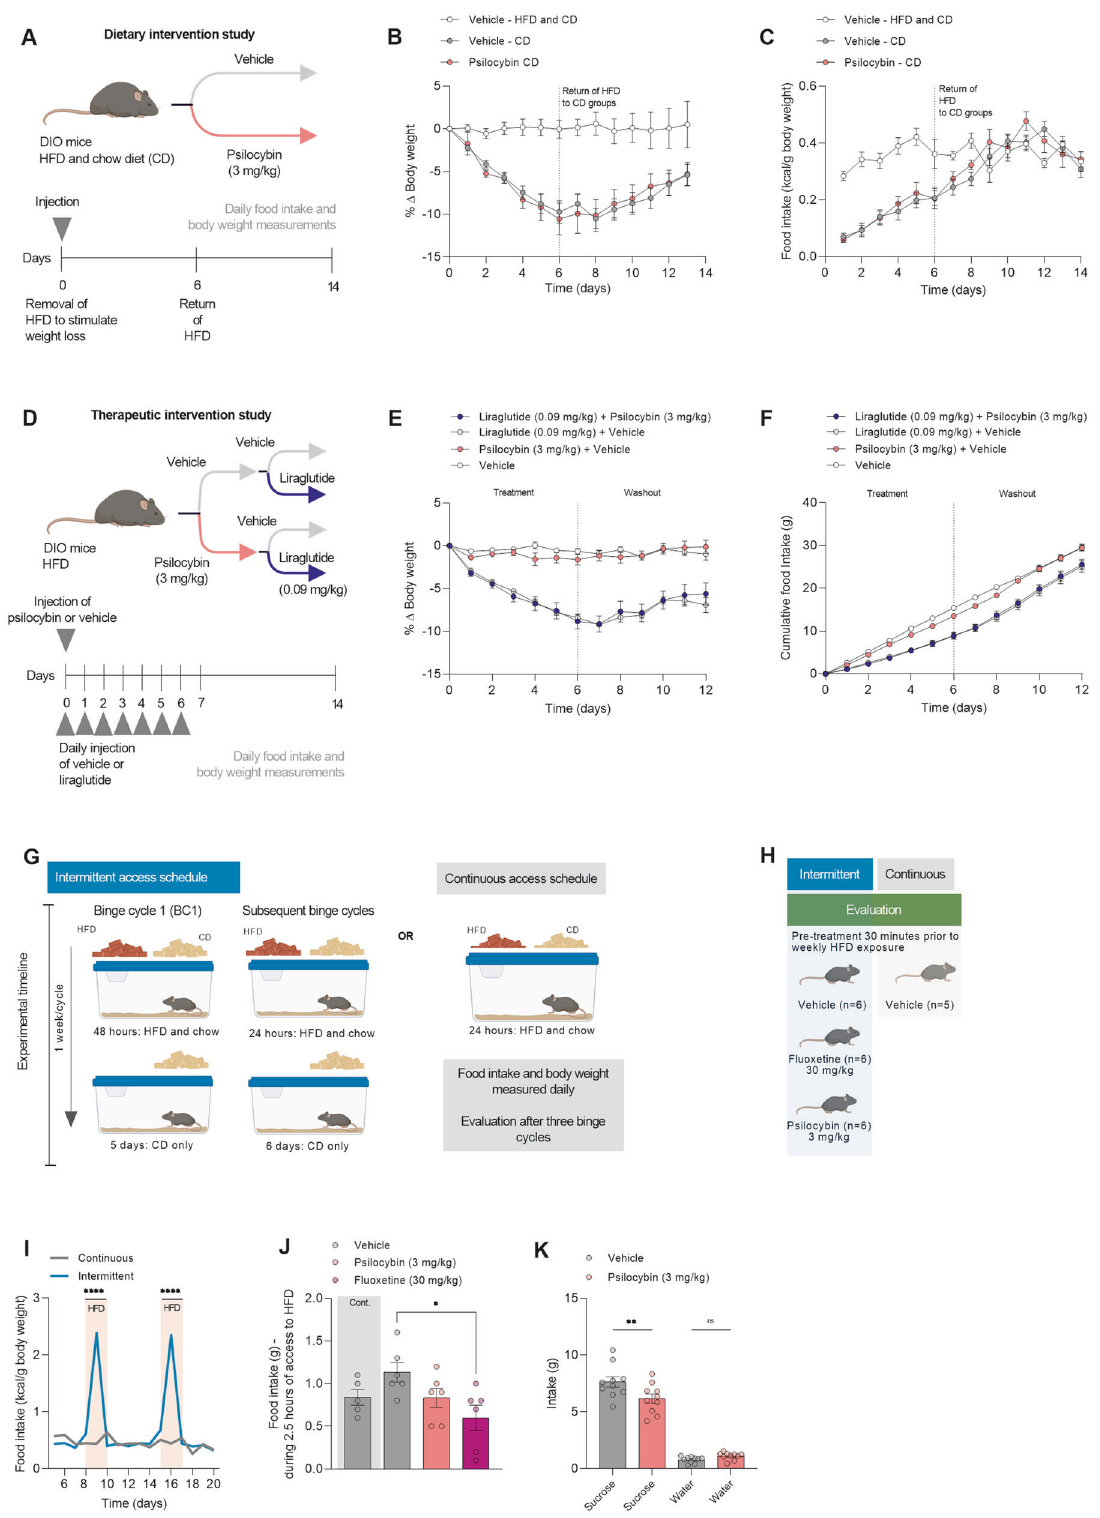
Psychedelic microdosing has been popularized for its bene fi ts